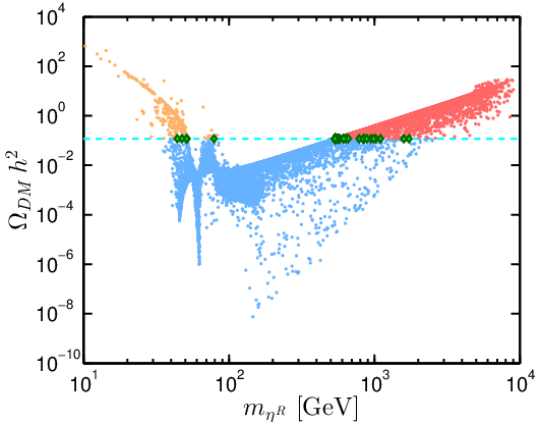
Figure 3 . Relic density for our dark matter candidate (cid:17) R as a function of its mass. We show a scan varying all the independent parameters of the model. Only points with h 1 mainly doublet are displayed. See the text for the color code.